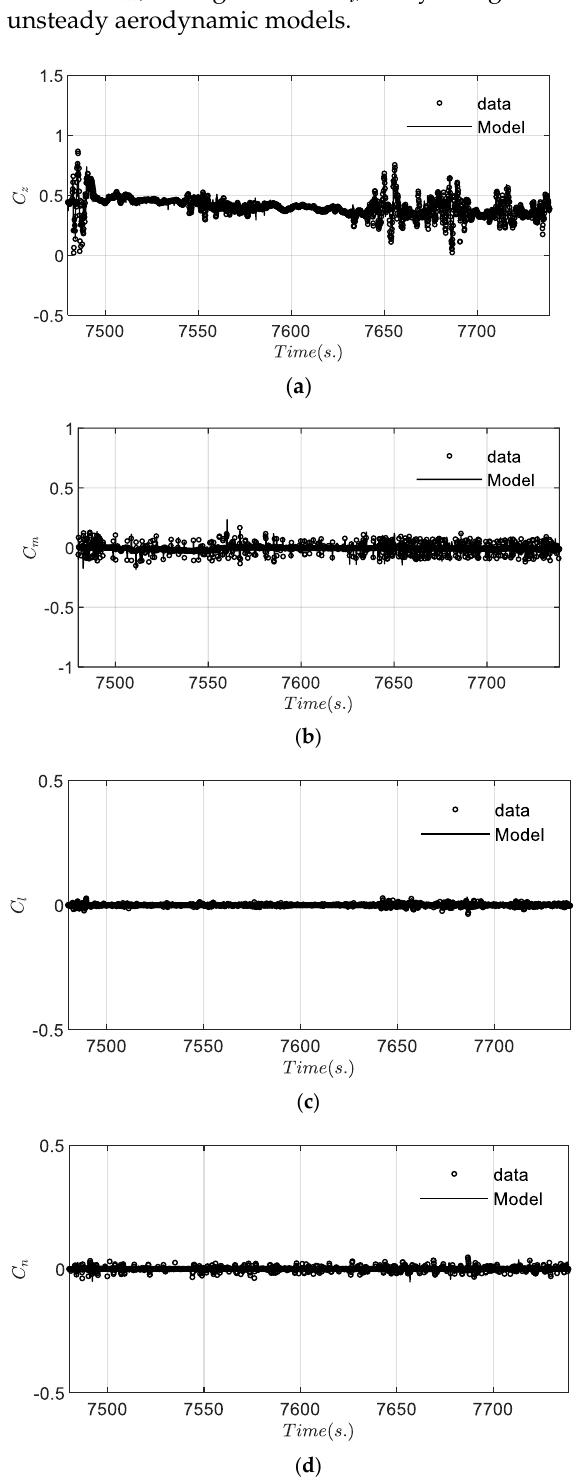
Figure 3. Main aerodynamic coefficients predicted by the nonlinear and unsteady aerodynamic models. ( a ) Time history of normal force C z ; ( b ) Time history of pitching moment C m ; ( c ) Time history of rolling moment C l ; ( d ) Time history of yawing moment C n .